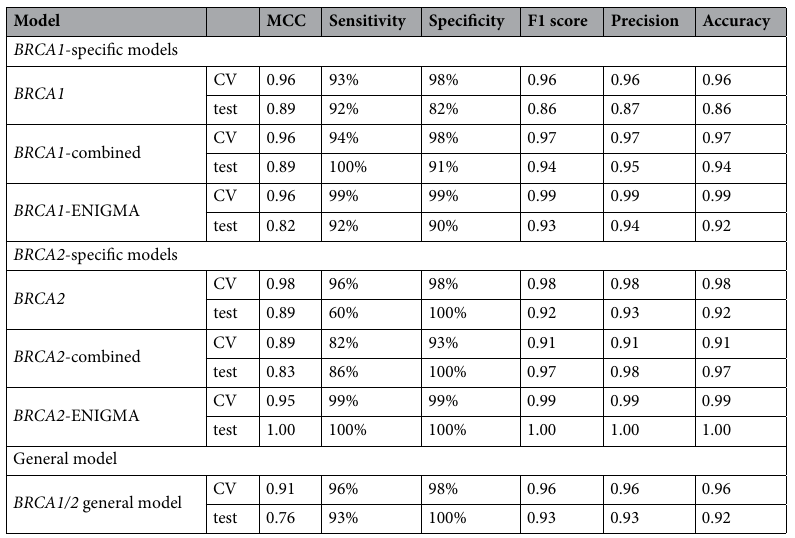
Table 1. Comparative performance of BRCA1/2 models across cross-validation and non-redundant blind test